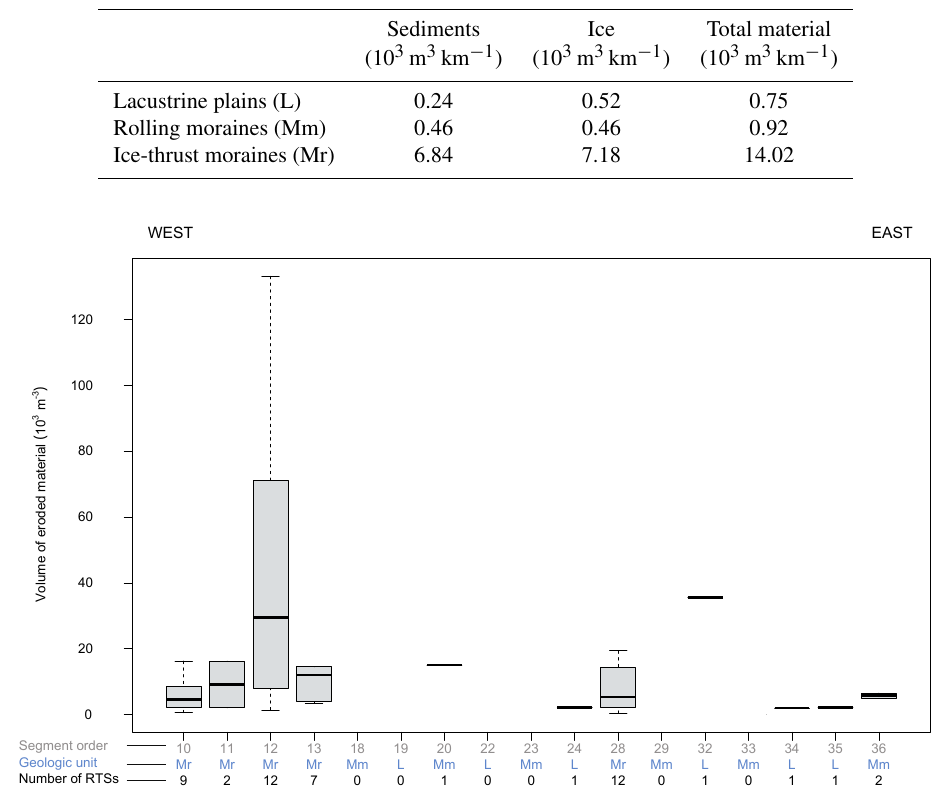
Figure 7. Box plot of volumes of eroded material (sediments and ice) per RTS for the coastal segments where RTSs initiated after 1972 occurred in 2011. Each bar corresponds to a coastal segment, following a geographic order from west on the left to east on the right. The number of the respective coastal segment is indicated in the first line on the x axis. The geologic units are indicated below the bars and referred to as L (lacustrine plains), Mm (rolling moraines), and Mr (ice-thrust moraines). The values on the lowest line of the x axis indicate the number of RTSs on the coastal segments.